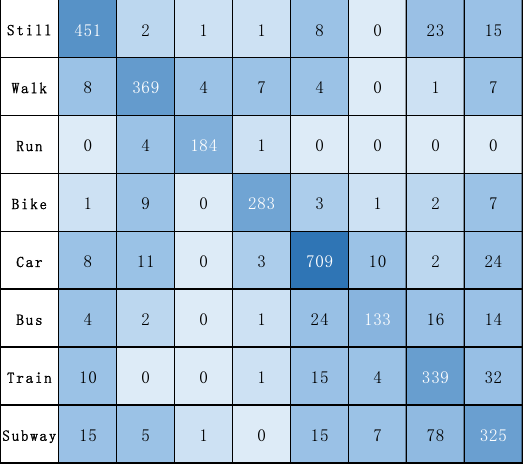
Figure 10. Precision, recall, and F1-scores of the eight classifications of the T2Trans model on the SHL dataset. Figure 11. Precision, recall, and F1-scores of the eight classifications of the T2Trans model on the HTC dataset. 4.7. Hyperparameter Fine-Tuning Hyperparameter fine-tuning is important to improve the performance of T2Trans. T2Trans has a total of eight convolutional layers. The different hyperparameter configurations are grouped into the eight groups a-h. F and K represent filters and kernel size of all eight convolutional layers, respectively, on the SHL dataset. For Group a, F = [64, 64, 32, 32, 32, 32, 32, 32] and K = [3, 3, 3, 3, 3, 3, 3, 3]. For Group b, F = [32, 32, 32, 32,